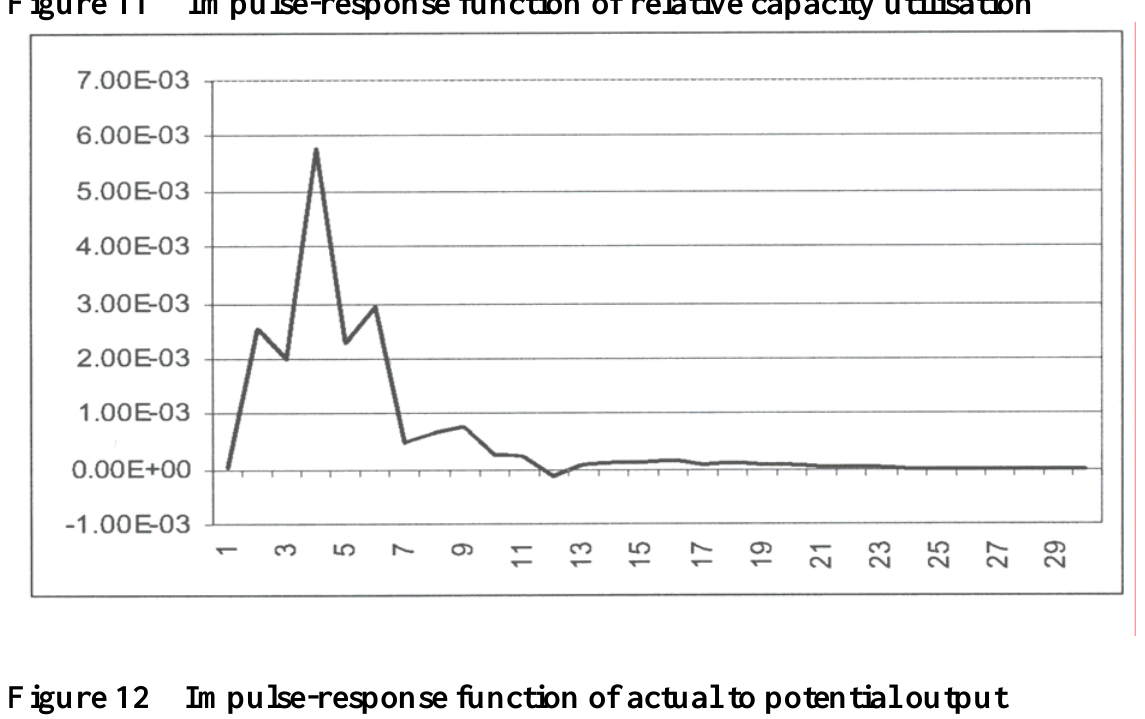
Figure 11 Impulse-response function of relative capacity utilisation